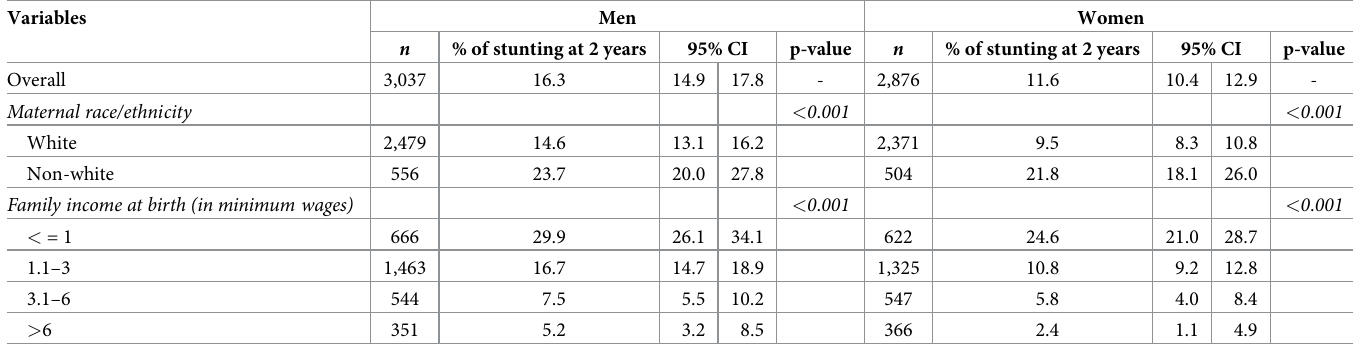
Table 2. Stunting at age 2 years by